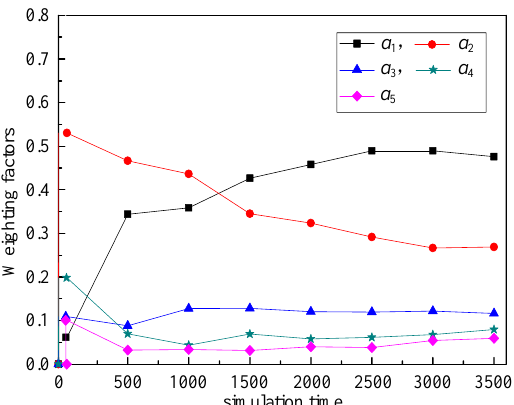
Figure 10. Relationship between weighting factors and simulation time: node 38.